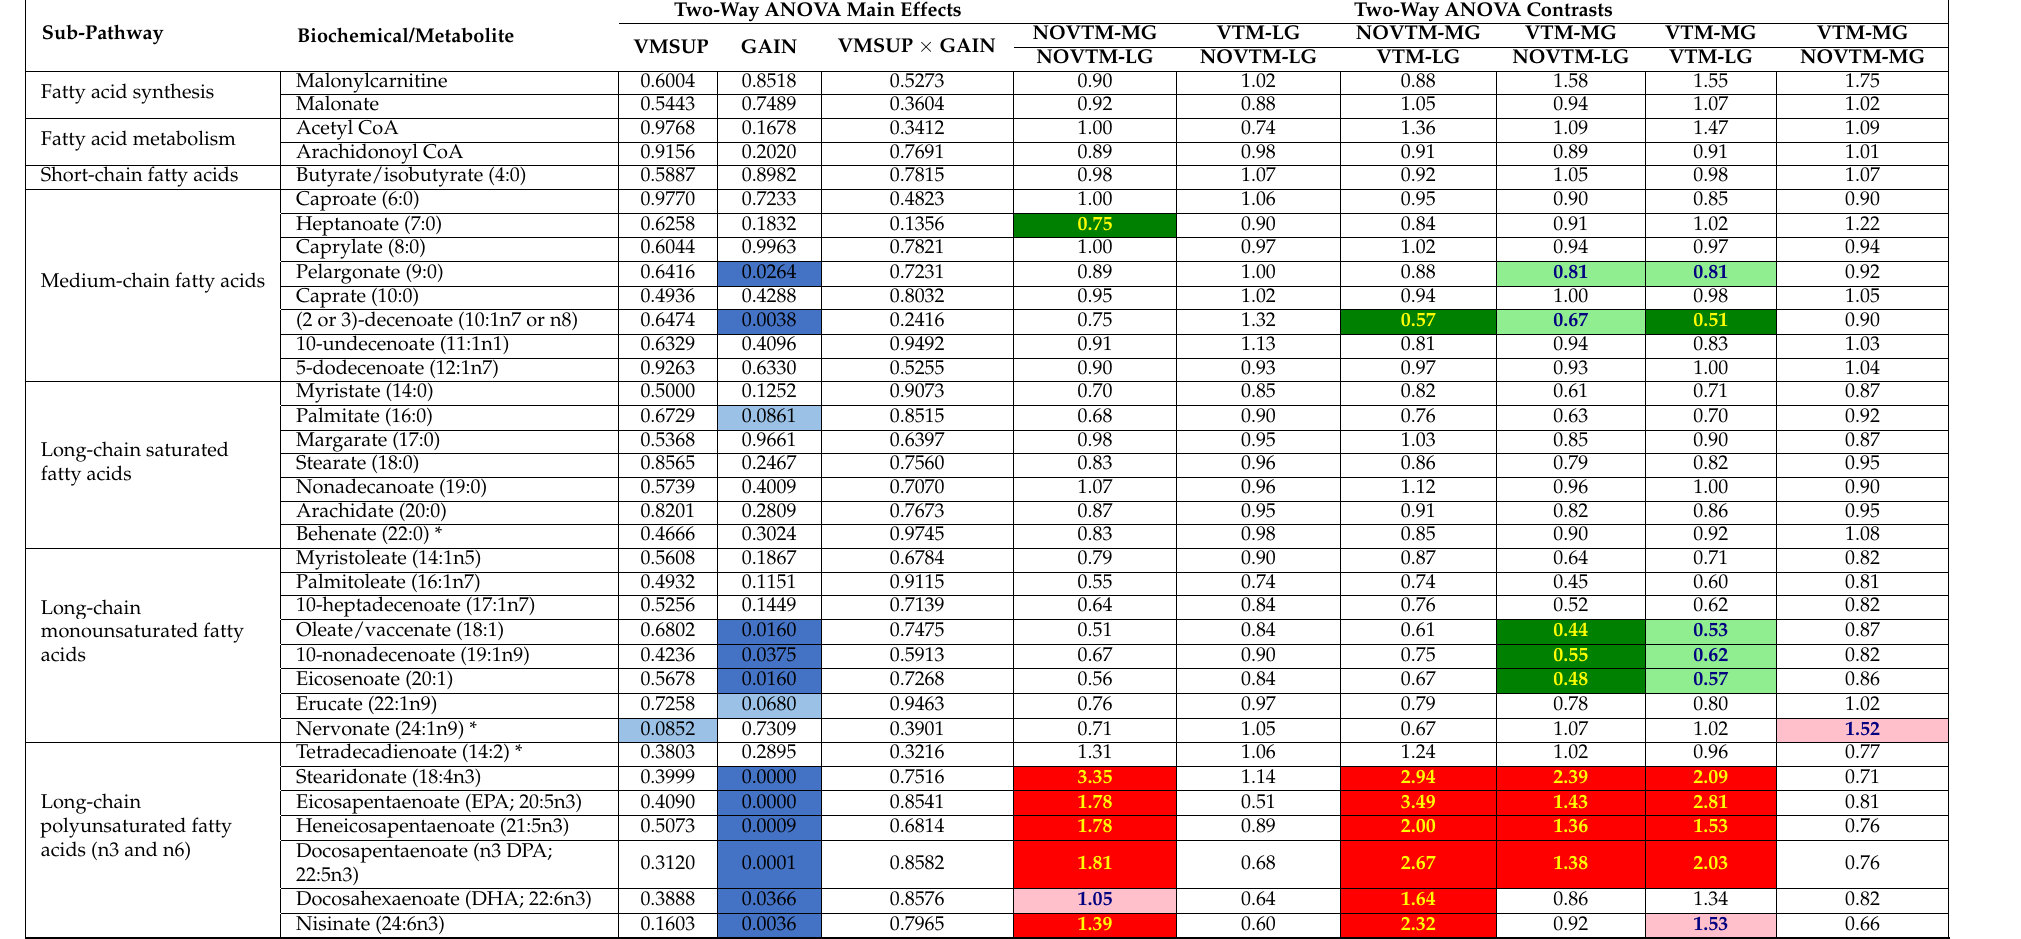
Table 2. Statistical heat map of biochemicals/metabolites involved in lipid metabolism